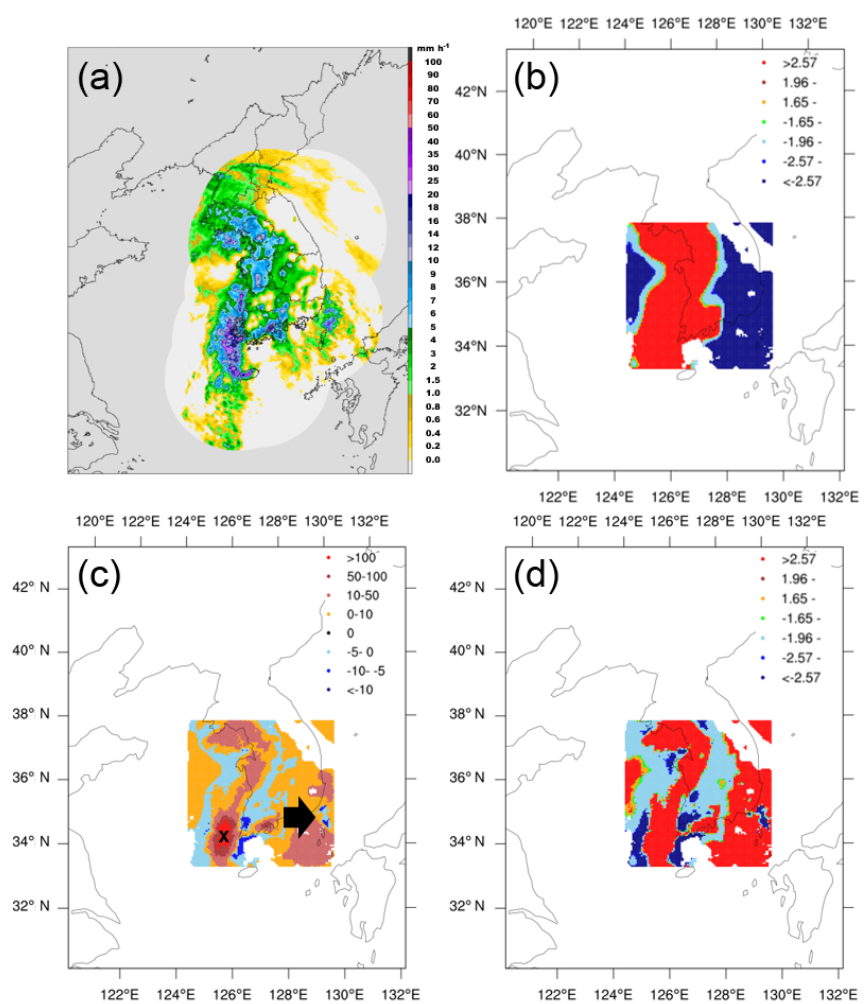
Figure 10. Same as in Fig. 9 but for an HPMP case at 17:00KST on 27 May 2013 and the computational domain of 33.43–38.05 ◦ N and 124.25–130.04 ◦